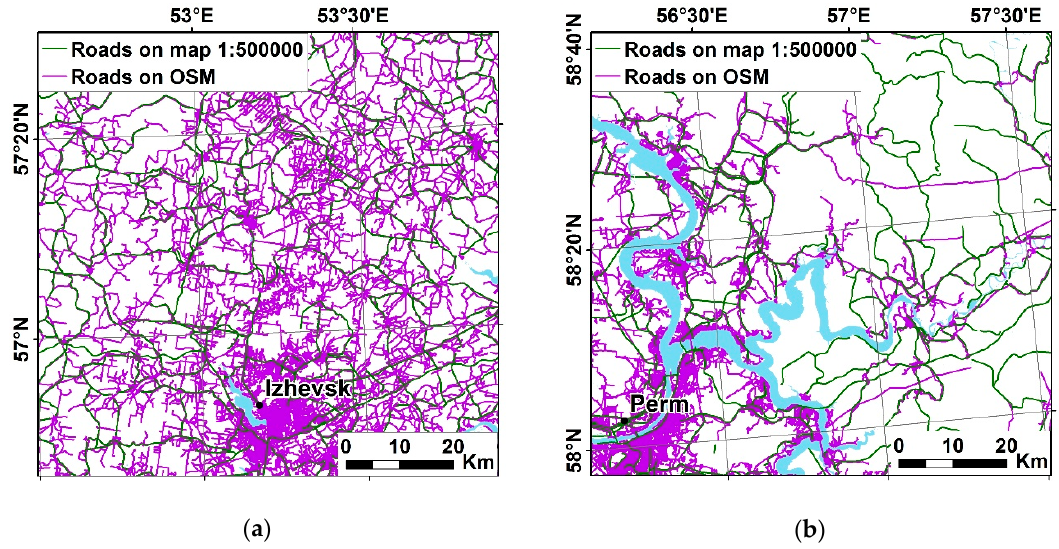
Figure 6. Differences in the detail of the road network on the topo map of scale 1:500,000 and on the OSM map: ( a ) high detailed OSM data; ( b ) gaps in OSM data. Table 3. Pressure scores assigned to different types of roads and railways from 1:500,000 topo map. Description Score